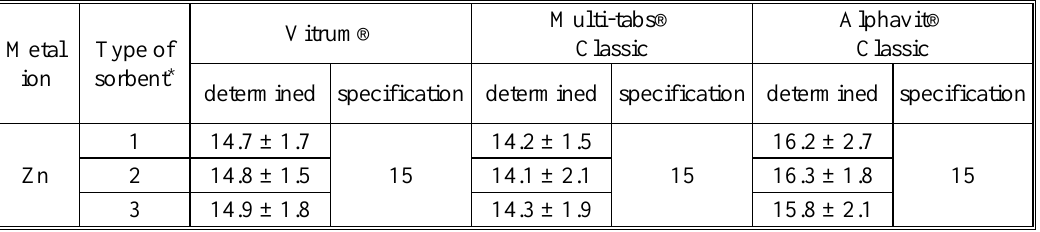
Table 2. Results of trace element determination in medicinal plants (µg/g, n = 5, P = 0.95)